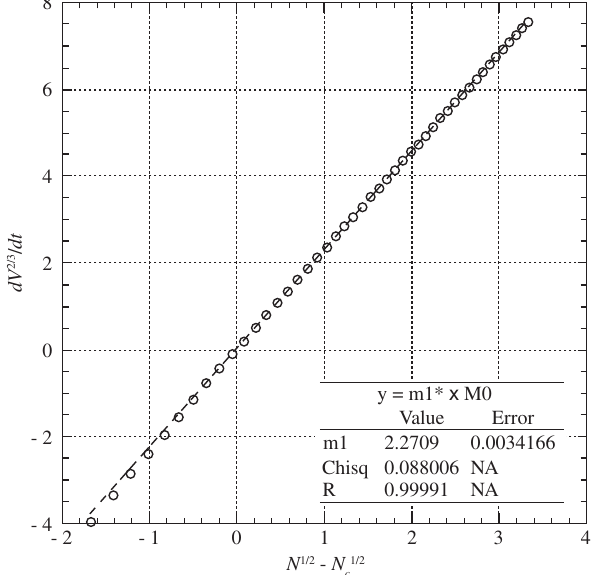
1/2 ). There is good c